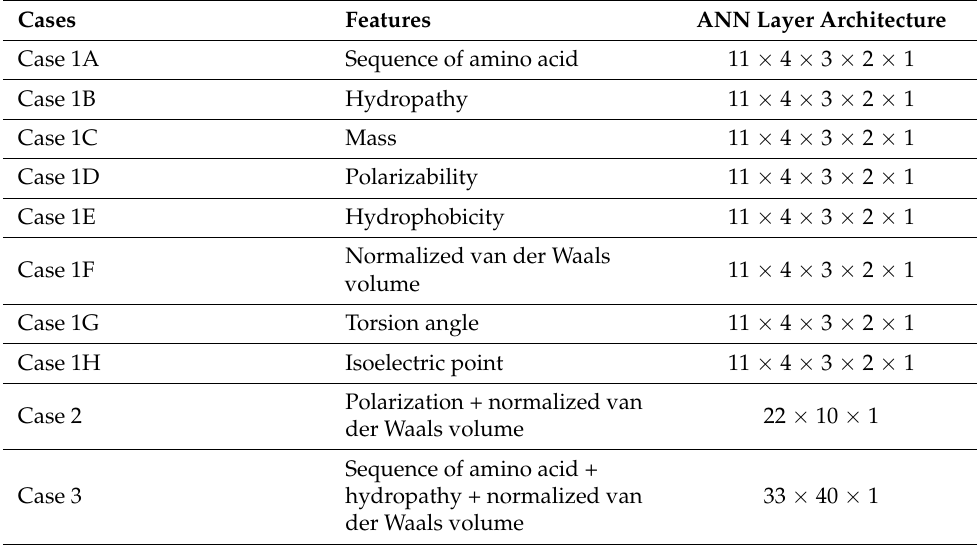
Table 1. Details of the ANN study cases. The physical properties and the architecture of the neural network are presented for each one of the sub–cases of case 1, along with the sub–cases that performed the best result for cases 2 and